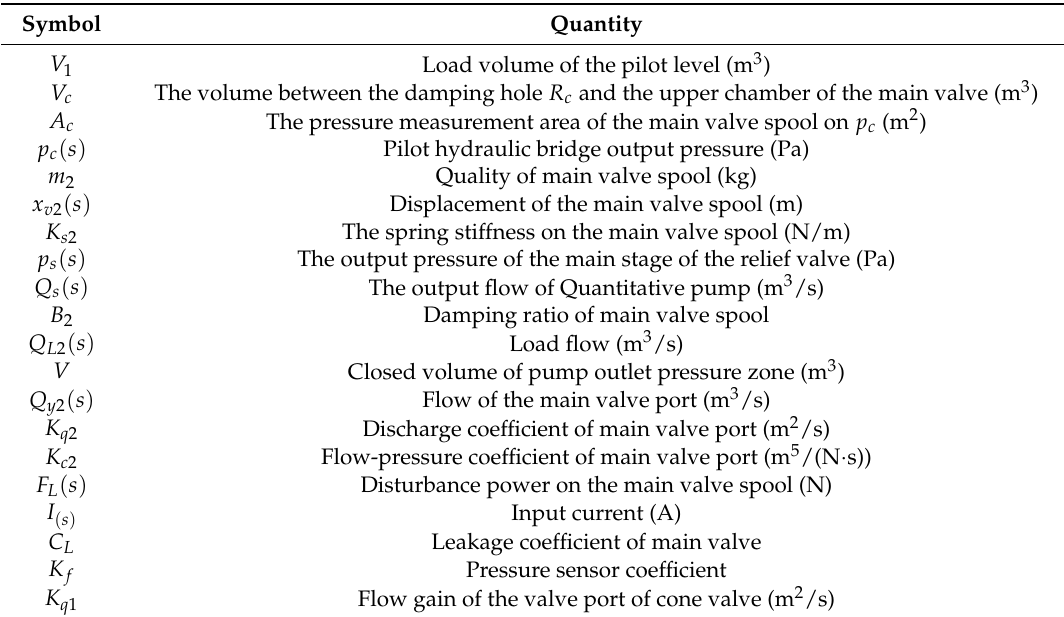
Table 2. Parameters value of equation of hydraulic